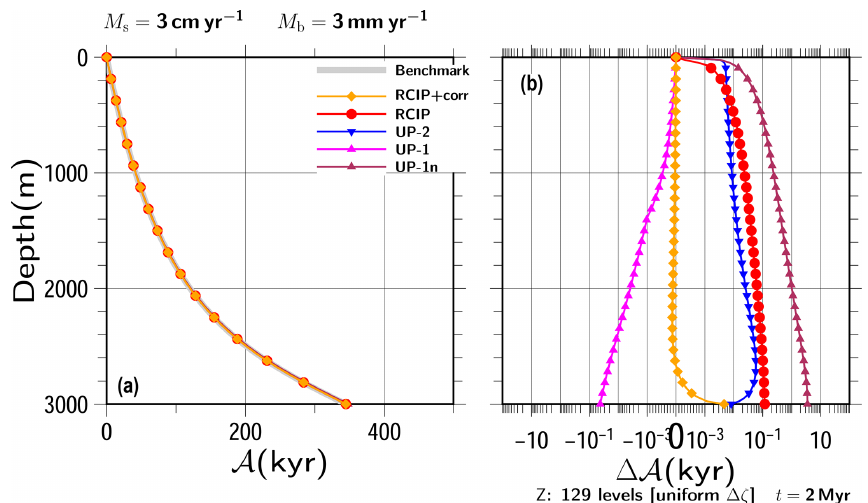
Figure 5. Same as Fig. 4a and b except for the experiment with M b = 3mmyr − 1